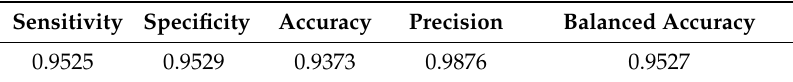
Table 5. Sensitivity, specificity, accuracy, precision, and balanced accuracy in the detection of cracks in tunnels using the Gabor filters invariant to